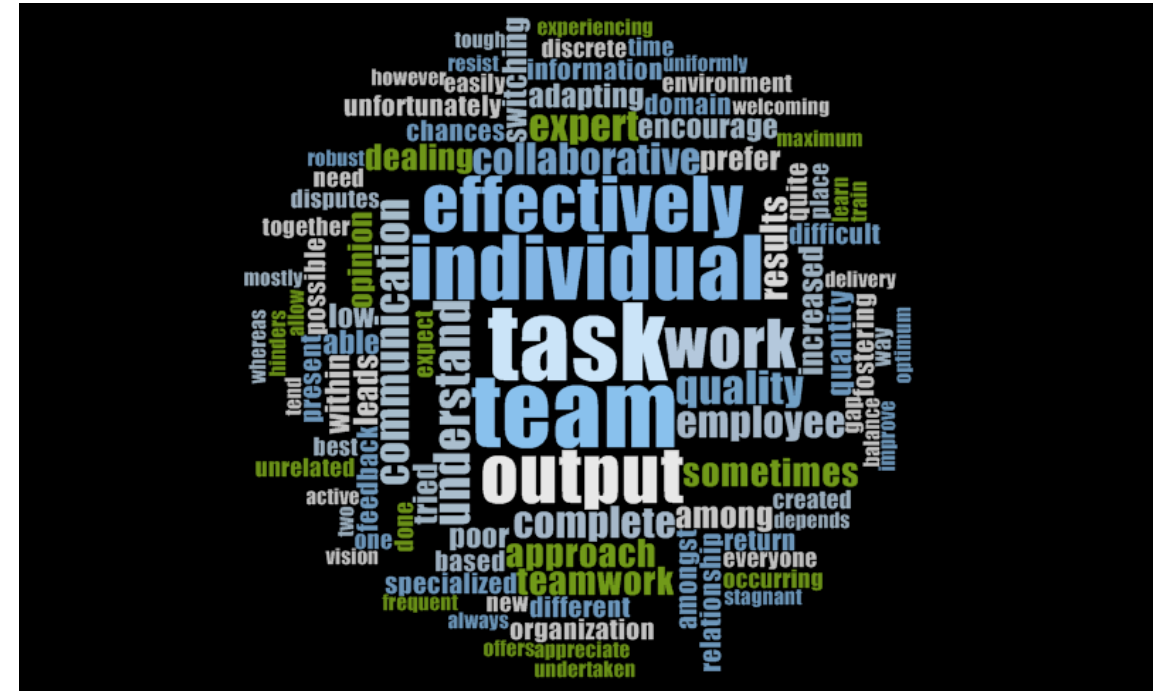
Figure 2. Text frequency analysis